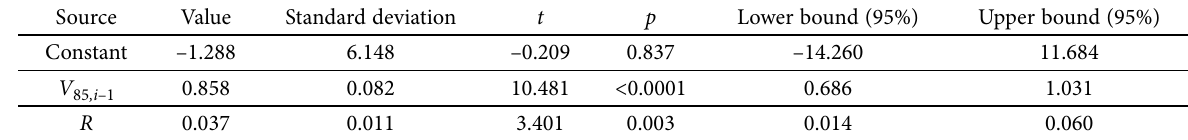
Table 4. Model parameter estimates ( V 85 ,c